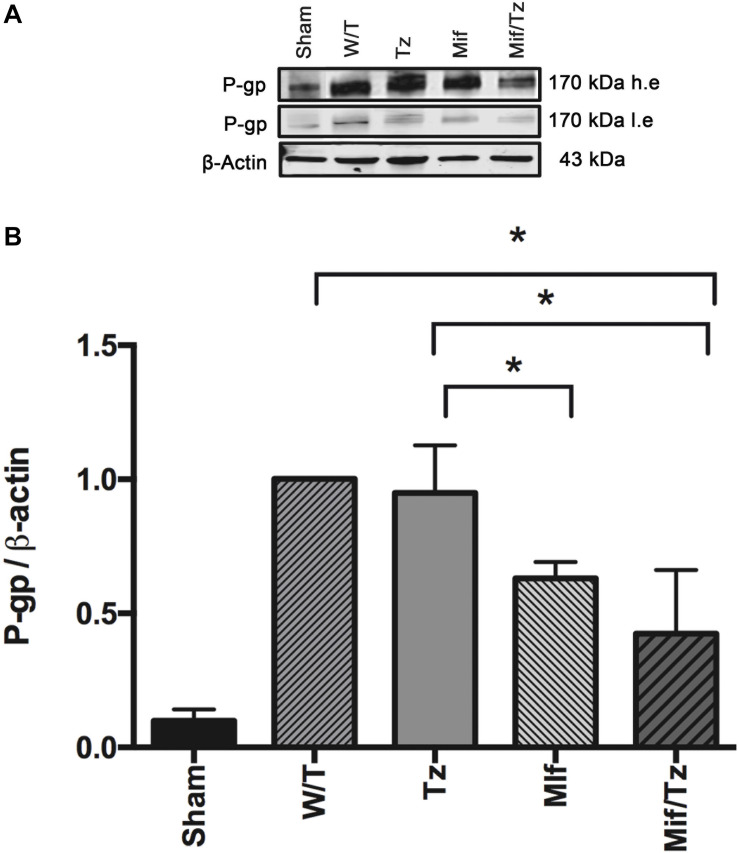
The quantification of P-gp levels at the end of the 3-week drug treatment evidenced a significant downregulation in the rats given mifepristone (Mif) or mifepristone/temozolomide (Mif/Tz) compared to those receiving no drug treatment (W/T) or temozolomide (Tz). (A) Representative Western blot; h.e., high exposure; l.e., low exposure. (B) densitometric analysis of the P-gp protein. Data are expressed as the mean ± SD from three independent experiments. *Significant difference (p < 0.05).